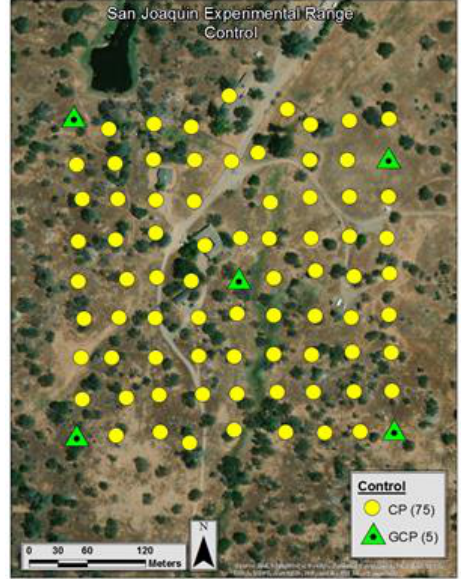
Figure 1. Research site at San Joaquin Experimental Range displayed with the total layout of 80 control points including GCP and CP configuration.